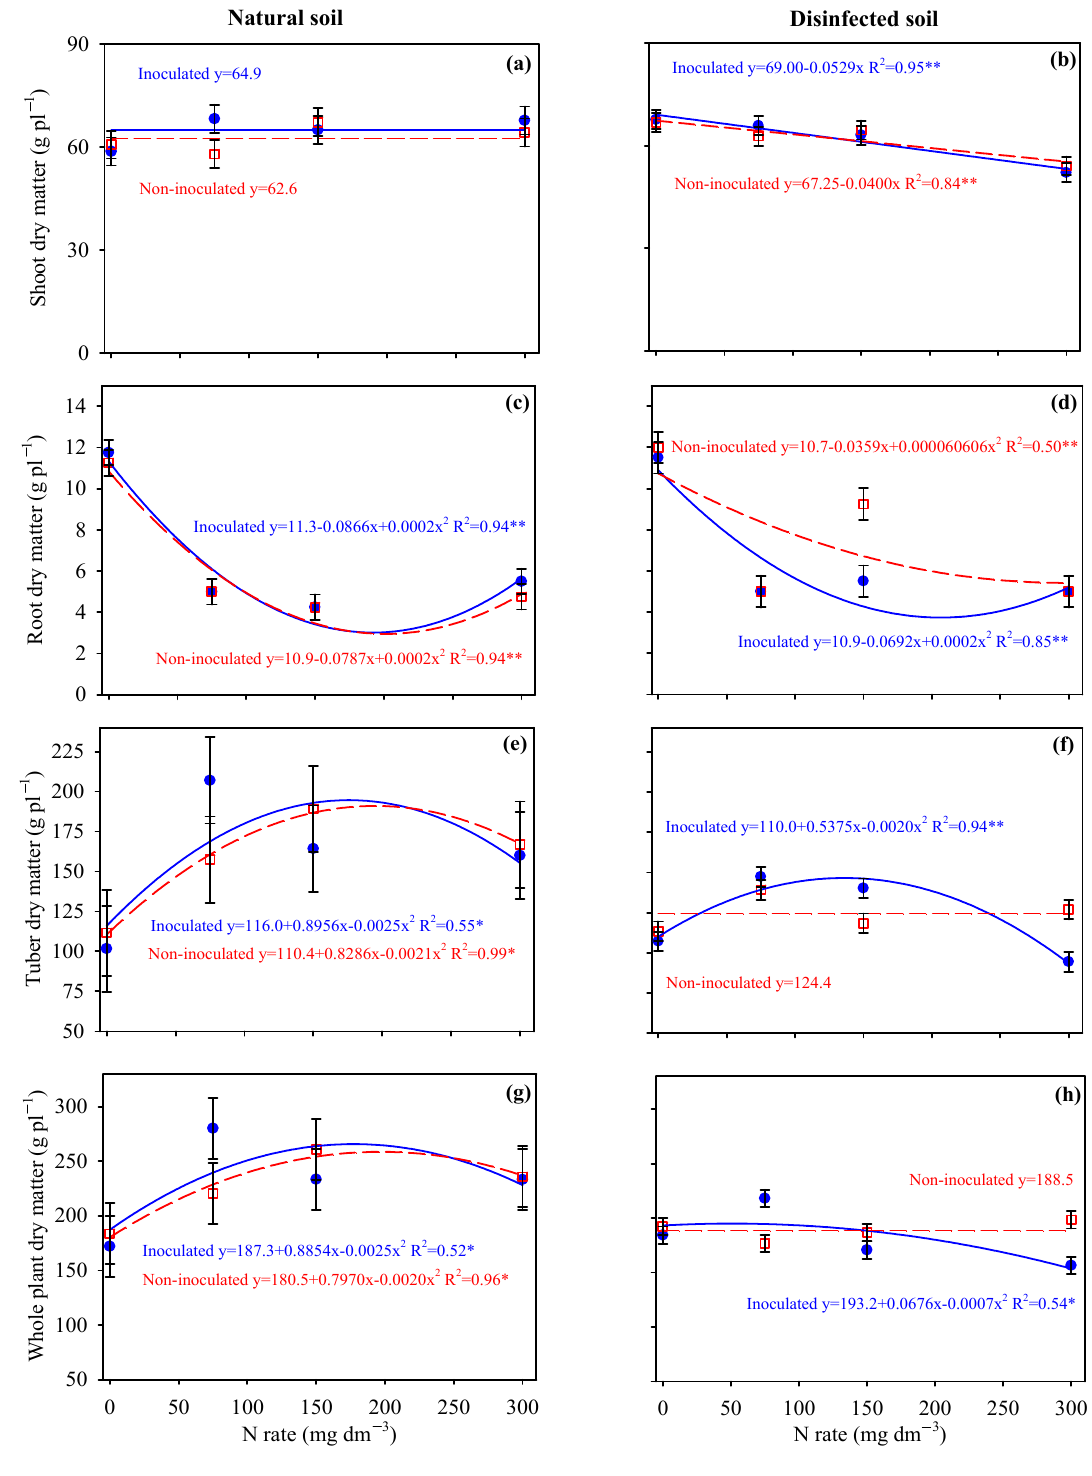
Figure 2. Dry matter accumulation in the shoot ( a , b ), root ( c , d ), tuber ( e , f ), and whole plant ( g , h ) of potato in response to N application rates and A. brasilense inoculation in natural and disinfected soil. Bars represent the least significant difference between A. brasilense inoculation in the same N rate at p < 0.05 according to the LSD test. * p < 0.05; ** p <